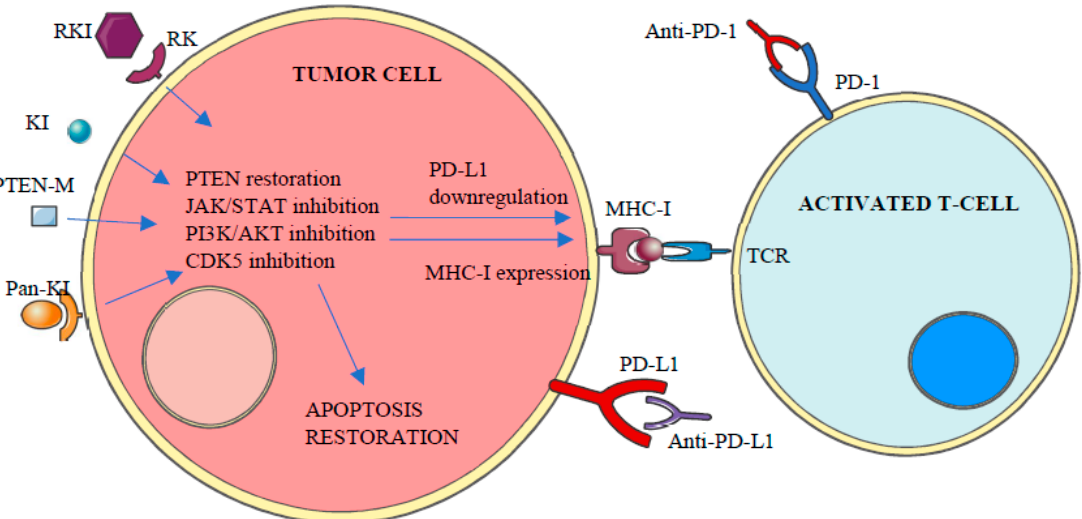
Figure 5. Protein kinase inhibitors can selectively inhibit the activity of their targeted altered kinase leading to PD-L1 downregulation and restoration of both apoptosis and MHC-I expression. Combination therapies with PD-1/PD-L1 blocking therapies will result in enhanced T-cell response against tumor cells. RK (receptor kinase), RKI (receptor Kinase Inhibitor), KI (kinase Inhibitor), Pan-KI (pan-kinase inhibitor), TCR (T-cell receptor). PTEN-M: PTEN modulator.